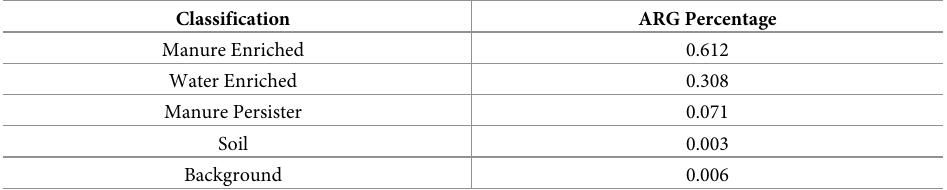
Table 1. The percentage and origin of ARGs in manure-treated effluent. ARG percentage represents the estimated percentage of abundance of observed